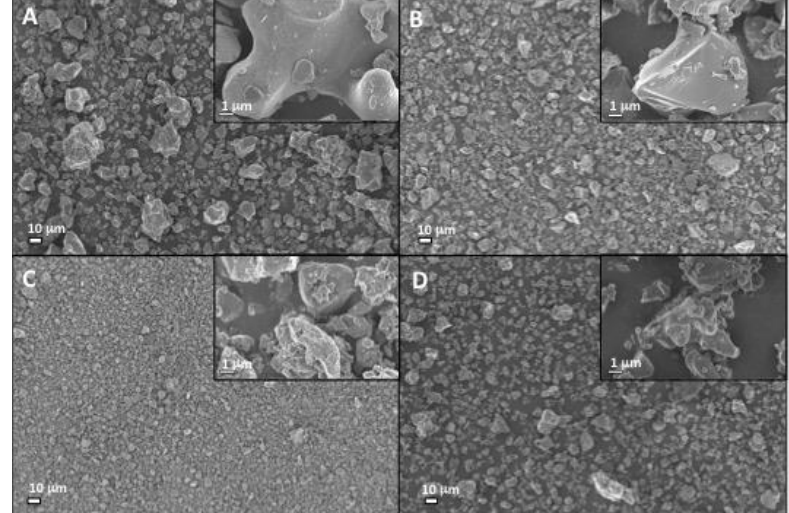
Figure 3. Secondary electron SEM images of precursor calcium salts: ( A ) αTCP2.1, ( B ) αTCP1.9, ( C )